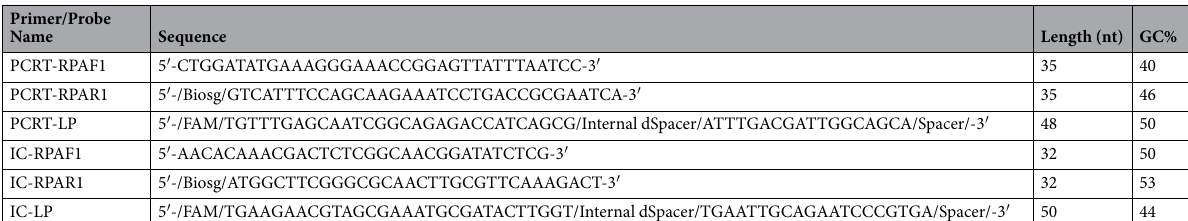
Table 2. Detail of Recombinase Polymerase Amplification (RPA) primers and probes designed to detect genus Pectobacterium and host